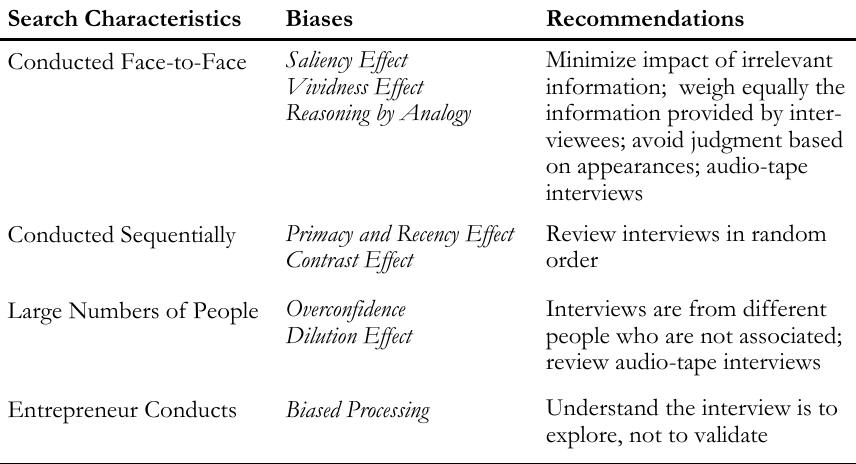
Table 1. Cognitive Biases and